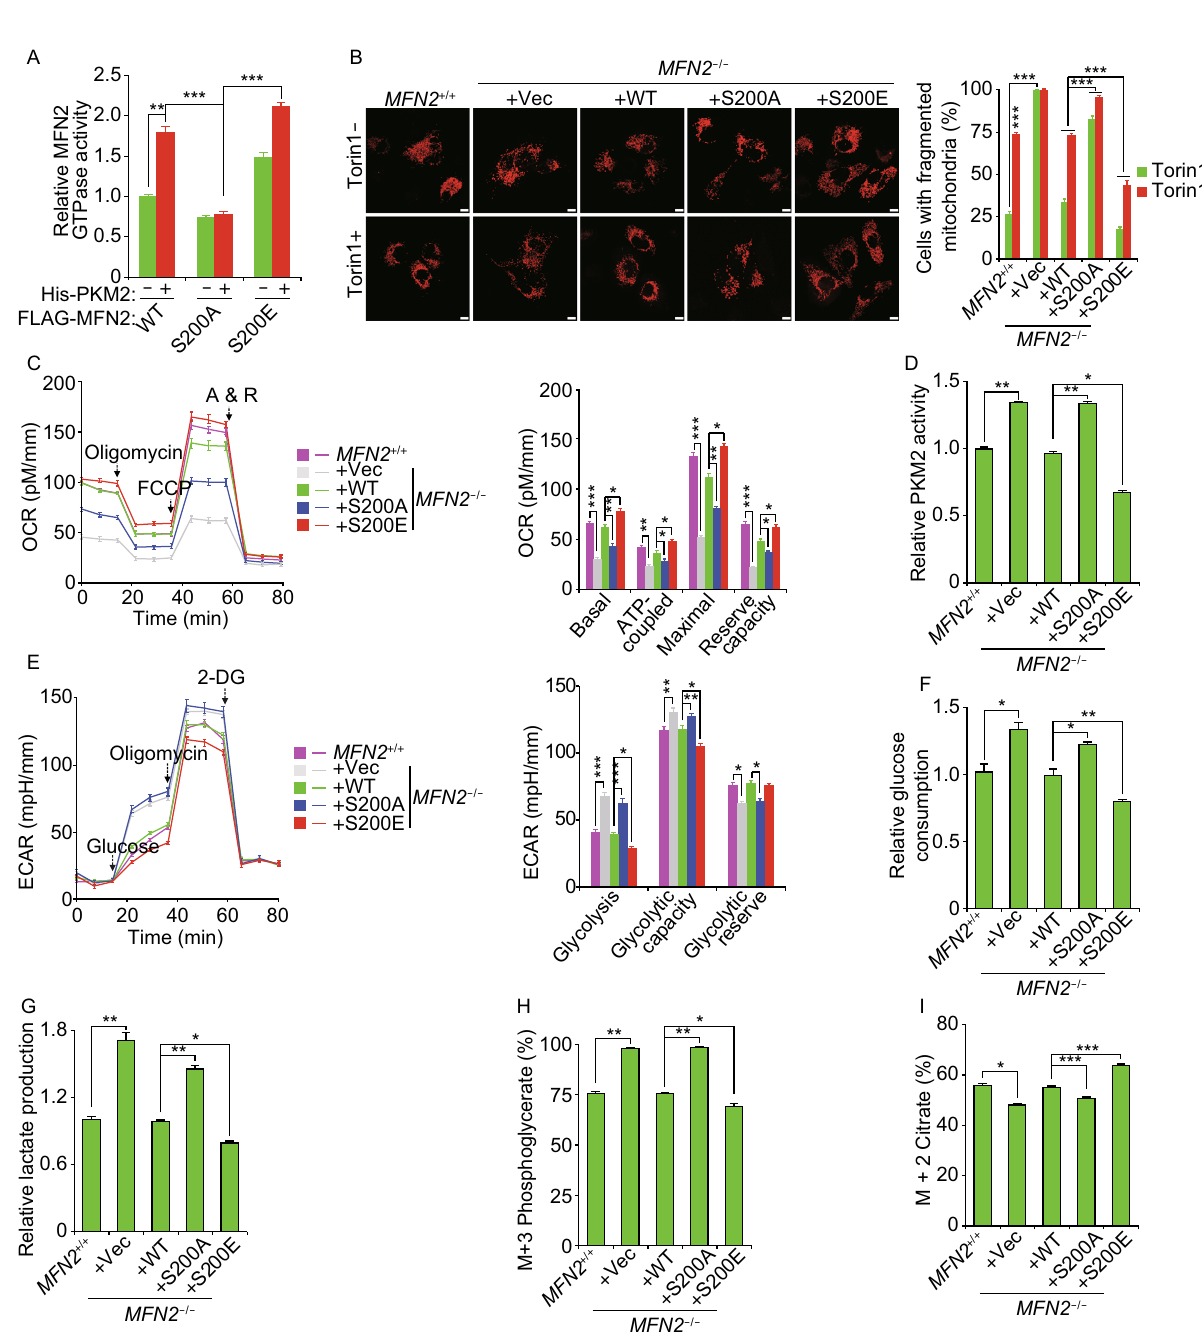
Figure 5. Phosphorylation of MFN2 enhances mitochondrial OXPHOS and attenuates glycolysis. (A) Effect of PKM2 on the GTPase activity of WT MFN2 or mutants of MFN2. (B) Representative images and statistical analyses showing the effect of MFN2 and its mutants on mitochondrial morphology in H1299 cells in the presence or absence of Torin1 (250 nmol/L) for 4 h. (C – I) Effect of MFN2 and its mutants on OCR (C), relative PKM2 activity (D), ECAR (E), relative glucose consumption (F), relative lactate production (G), ratio of M+3 2-phosphoglycerate/3-phosphoglycerate (H) and M+2 citrate (I). Data are shown as mean ± s.e.m. * P < 0.05, ** P < 0.01, *** P < 0.001, n =